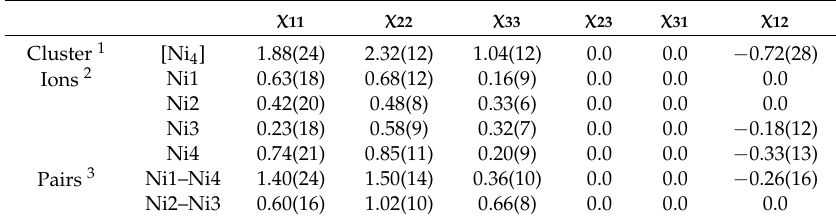
Table 3. Susceptibility tensor components in ( µ B /T) from PND for the cluster, individual ions, and antiferromagnetic pairs. As a footnote: the respective goodness-of-fits in the combined refinement are relative to the three different datasets.